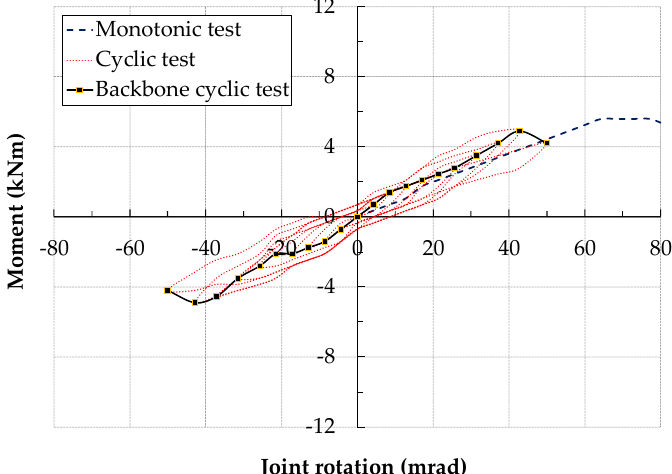
Figure 5. Cyclic moment-rotation response: SFSc2A-hybrid joint with double web and flange steel cleats.